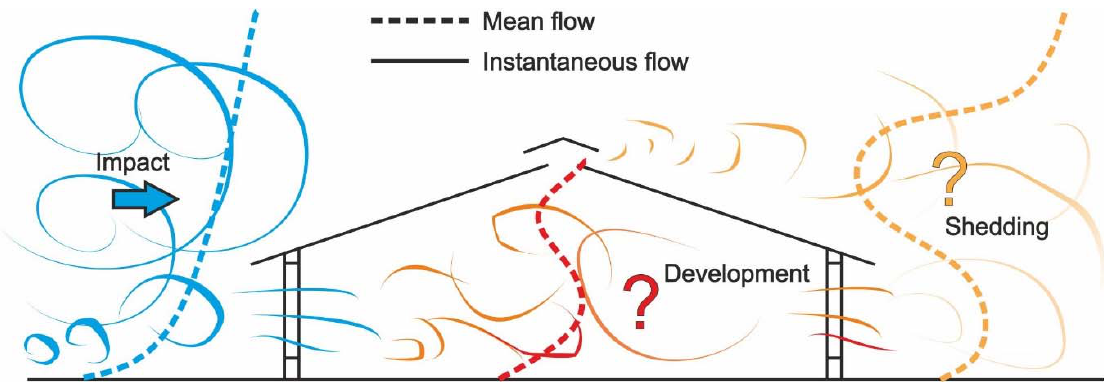
Figure 1. Sketch of possible instantaneous (solid lines) and mean (dashed lines) flow characteristics of the turbulent flow impacting a naturally ventilated livestock building (NVLB) (blue), developed within the NVLB (red), and shed by the NVLB geometry (orange). The question marks represent the unknown ammonia emission and dispersion. The flow is from left to right.